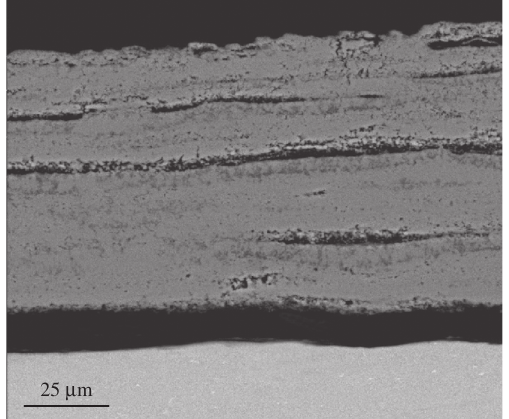
Figure 9: Micrograph (SEM/BEI) of a cross section of Ti-6Al-4V oxidized in air at 850°C for 24